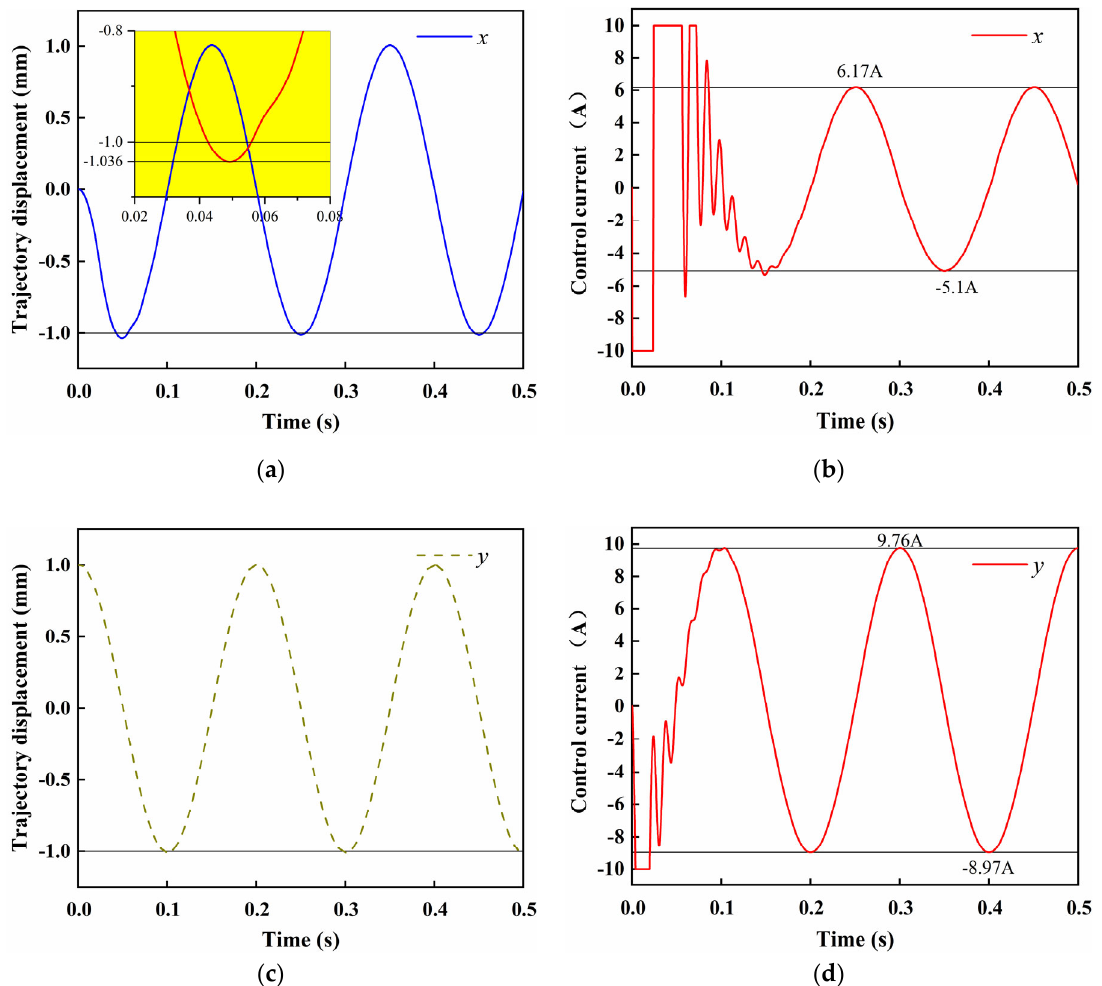
Figure 7. Simulation results of trajectory tracking. ( a ) Trajectory in X direction; ( b ) Control current in X direction; ( c ) Trajectory in Y direction; ( d ) Control current in Y direction.